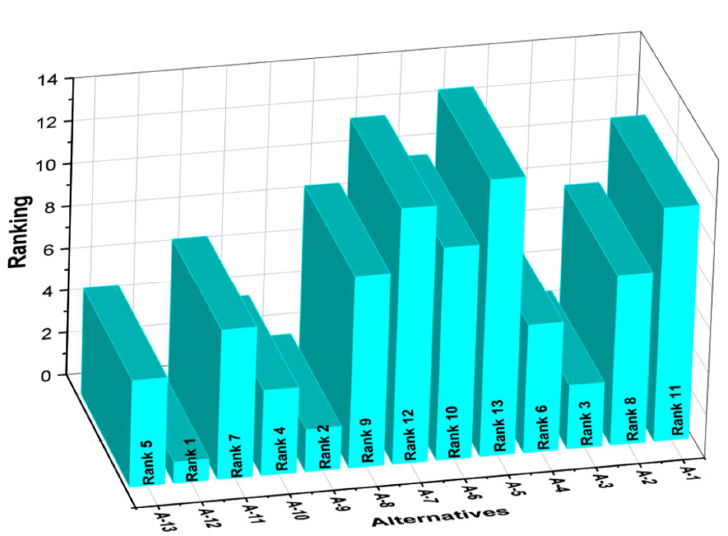
Figure 5. Ranking of hip implant alternatives.